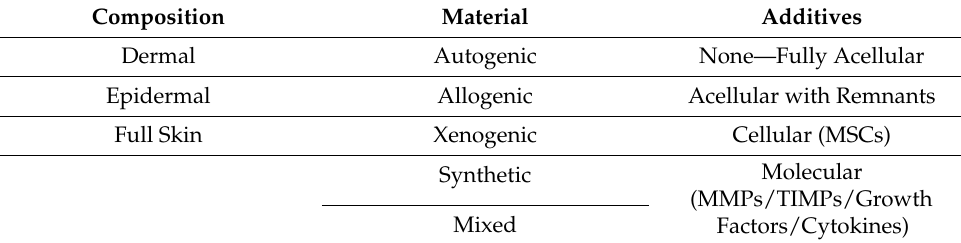
Table 2. Categories of Skin